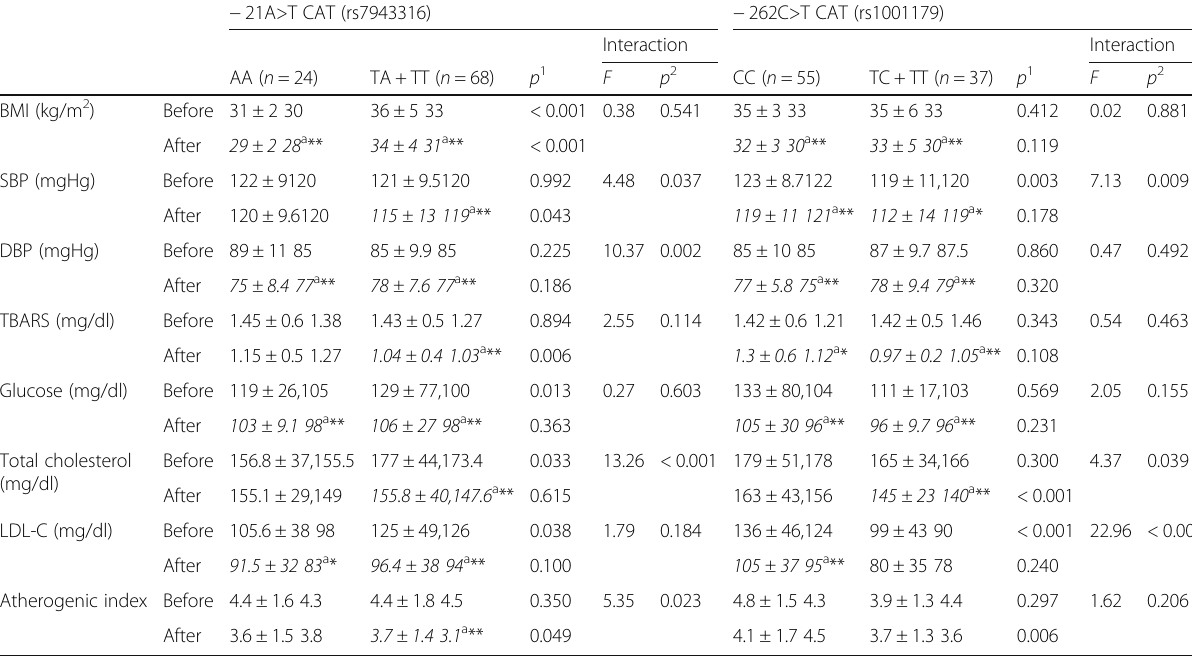
Table 4 Effect of the dietary intervention on participants stratified by − 21A>T CAT (rs7943316) and − 262C>T CAT (rs1001179) polymorphisms, and interaction between period and group − 21A>T CAT (rs7943316) − 262C>T CAT (rs1001179)